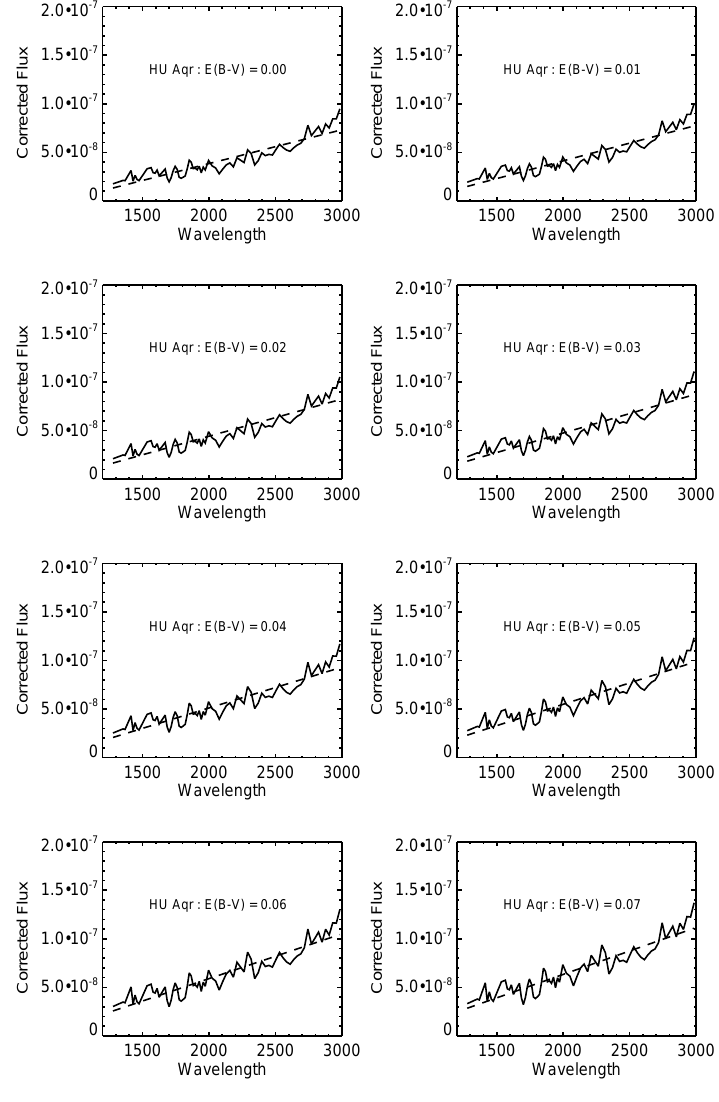
Fig. 7. Reddening determination for HU